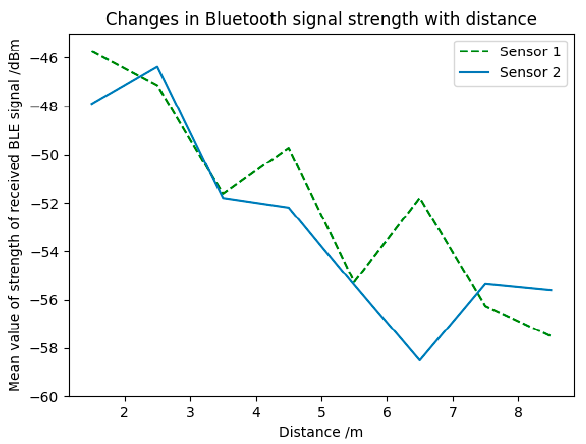
Figure 1. Changes in BLE RSS value with distance during experiments.